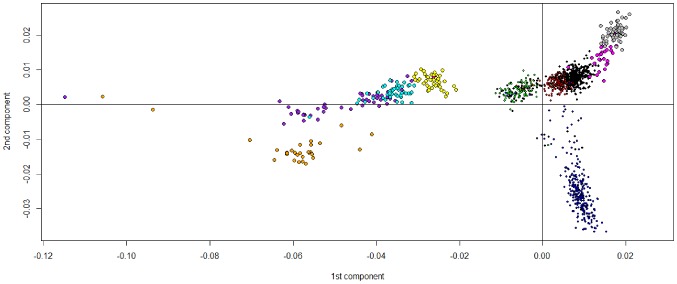
SNP-Based PC of 1,262 individuals from 10 sub-populations.The Italian population plotted onto the first two principal components defined by the European HGDP-CEPH populations and CEU HapMap data. Scatter plot of the first two principal components, obtained using R software (prcomp). Analysis based on 125,799 autosomal SNPs. Individuals included belong to Northern Italy (N-IT): black dots, Central Italy (C-IT): red dots, Southern Italy (S-IT): green dots, Sardinian (SAR): blue dots, CEU HapMap (CEU); light blue dots, Beduoin (BED): purple dots, Druze (DRU): yellow dots, Mozabite (MOZ): black triangles, Palestinian (PAL): red triangles, French (FRE): green triangles. The top 100 Eigenvectors and associated Eigenvalues for this plot are given in Supplementary Material: Figure S2 (panel a).